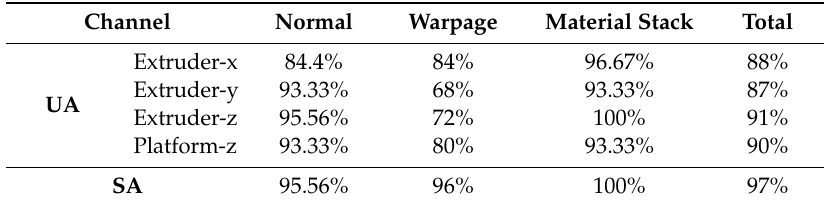
Table 6. The predicted results for uniaxial acceleration (UA), and synthetic acceleration (SA) using the BPNN model.